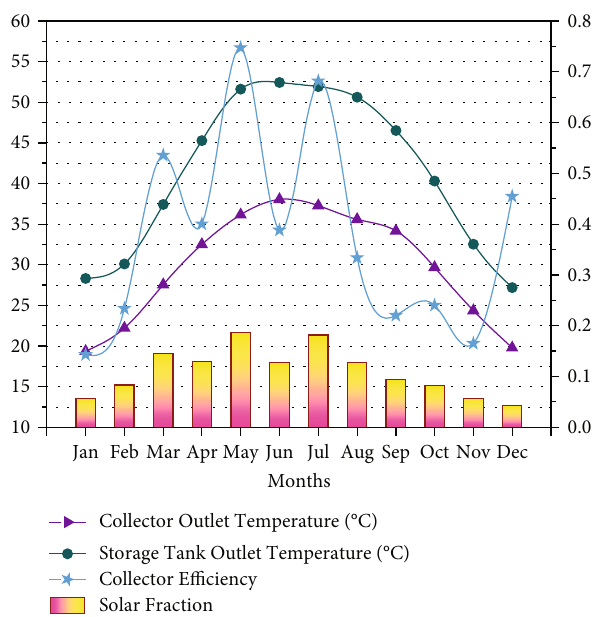
Jan Feb Mar Apr May Jun Jul Aug Sep Oct Nov